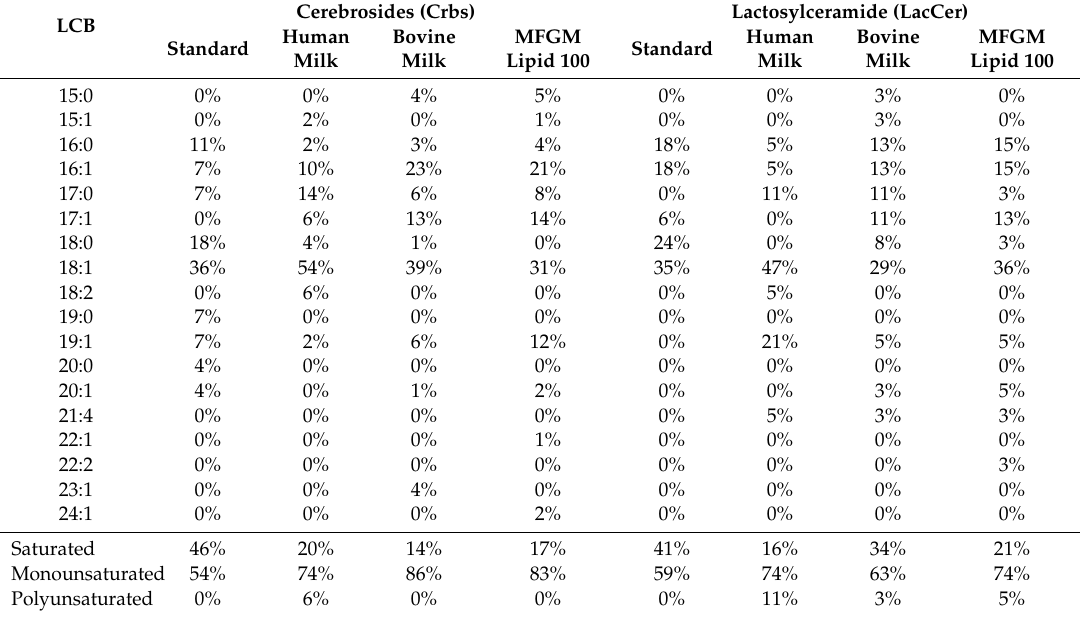
Table 1. Proportion of distinct species containing specific long chain bases (LCB) in commercial standards, human milk a , bovine milk and a commercial milk-fat-globule-membrane-enriched dairy ingredient (MFGM Lipid 100).